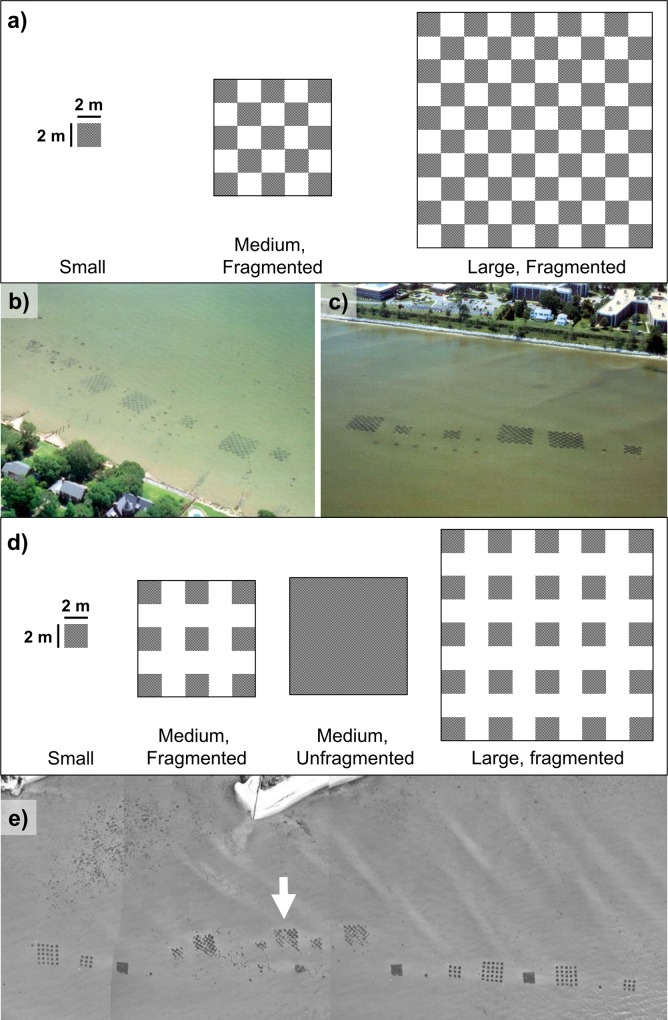
(a) A schematic of the experimental design employed in Experiment 1. Lower middle panels depict aerial photographs of transplants from Experiment 1 in the (b) James River Estuary, and (c) York River Estuary, taken June 1997 (approximately nine months after the initial planting) (from [35]). (d) A schematic of the experimental design employed in Experiment 1. Bottom panel depicts aerial photograph of transplants from Experiment 2 in the York River Estuary taken in June 1999 (approximately nine months after the initial planting). The arrow in panel (e) denotes a separate set of transplants conducted one-year prior for unrelated purposes, and is not reported on here.